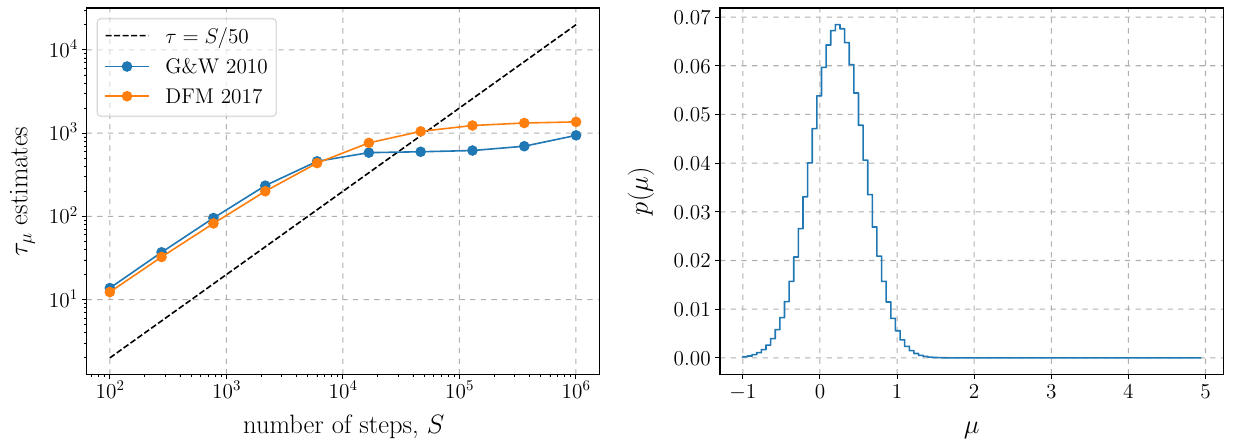
Fig. 3 Estimateoftheautocorrelationtime τ μ (obtainedusingboththe original method proposed in Ref. [45] and the alternative one discussed by the emcee3 authors [49,50]) as a function of the number of samples